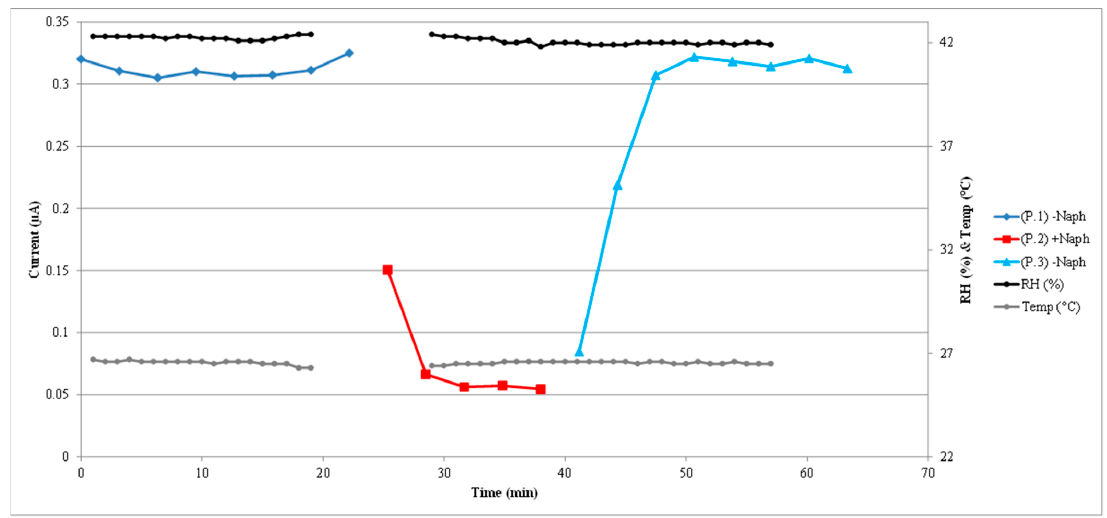
Figure 4. Typical sensor current response to one cycle of naphthalene contamination and cleaning. Micro-amp sensor current and absorbance measurements were made simultaneously. P1 corresponds to the initial fresh air introduction (baseline phase), P2 corresponds to naphthalene + air introduction (contamination phase), and P3 corresponds to the re-introduction of fresh air only (cleaning phase). The sensor current values can be read on the left-hand scale of the y -axis. The purple line (WL265.0) corresponds to the absorbance at 265 nm for naphthalene. Absorbance values can be read on the right-hand scale of the y -axis. An increase in absorbance corresponds to an increase in naphthalene concentration. Color lines with markers indicate sensor current measurements every 3 min. The purple line appears to be continuous because the spectrophotometer made absorbance measurements every minute. Sensor current decreased as naphthalene concentration increased.